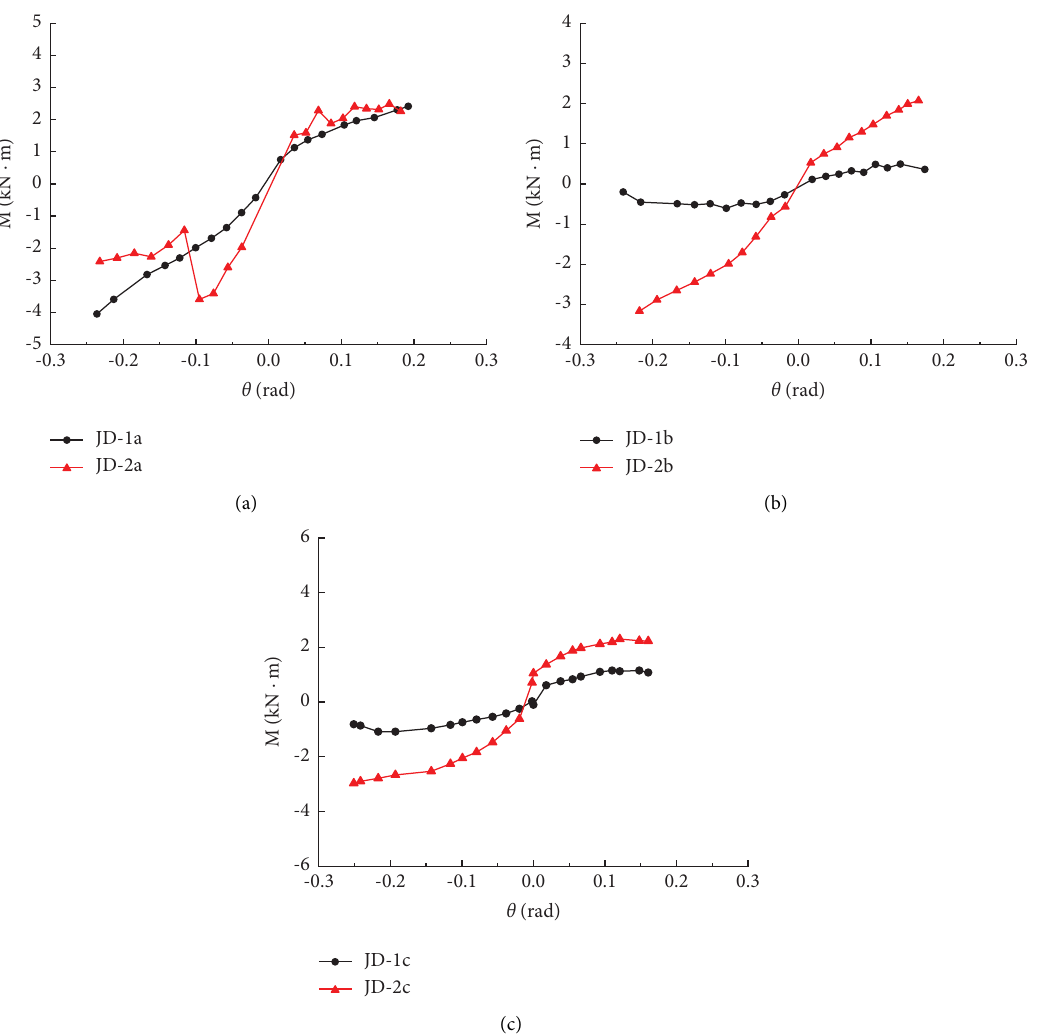
Figure 10: Moment-rotation backbone curves of joint after reinforcement with steel plate: (a) Tou mortise-tenon joints. (b) Ban mortise- tenon joints. (c) Dovetail mortise-tenon